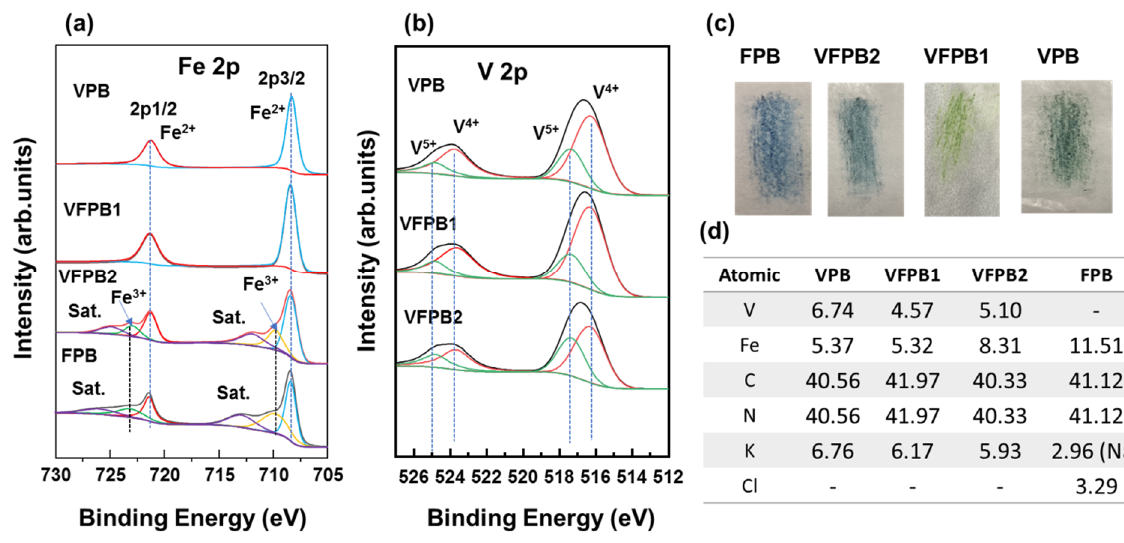
Figure 2. High-resolution X-ray photoelectron spectra of ( a ) Fe and ( b ) V; ( c ) photographs of Prussian blue-green sample powders on weighing paper; and ( d ) atomic percentage of V, Fe, C, N, K(Na), and Cl in VPB, VFPB1, VFPB2, and FPB.